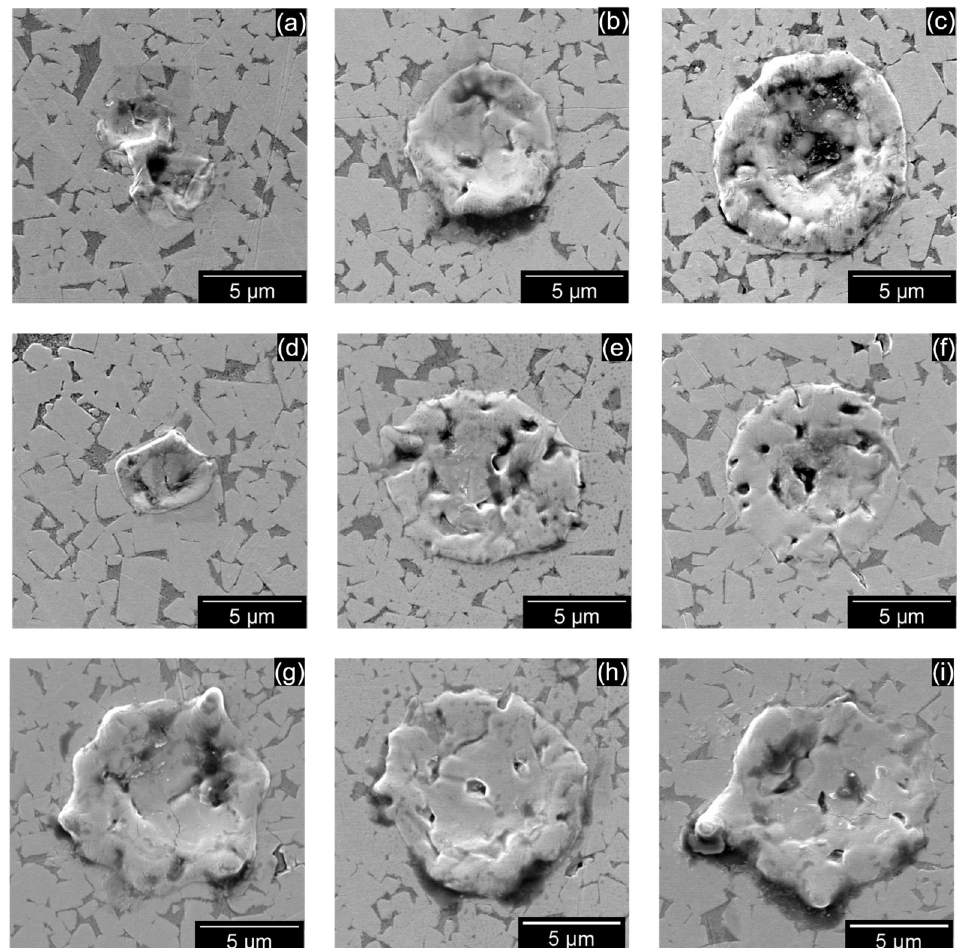
Figure 6. Single discharge craters for ( a ) 90 V, ( b ) 100 V, ( c ) 110 V using EDM oil with carbon nanofiber powder, ( d ) 90 V, ( e ) 100 V, ( f ) 110 V with alumina powder and ( g ) 90 V, ( h ) 100 V, ( i ) 110 V with silicon powder.